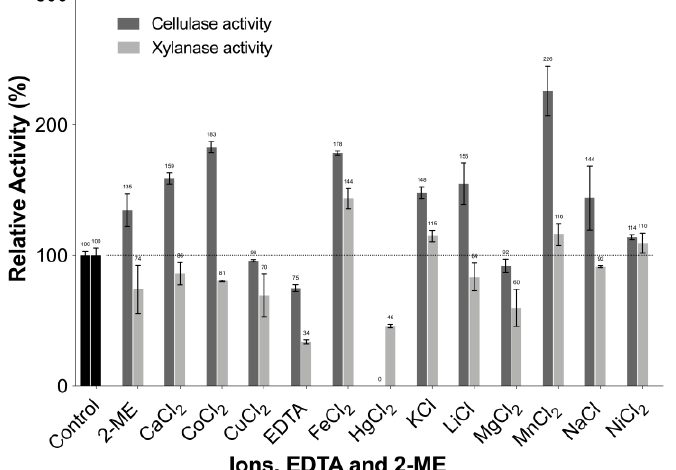
Figure 7. Effect of metal ions, EDTA, and 2-ME on cellulase and xylanase activity of TtCel7A. Activity was measured at 1 mM concentration and incubated in 0.6% ( w / v ) CMC and xylan in 50 mM acetate buffer, pH 5.5. The activity observed without any element was used as a control and considered 100%.